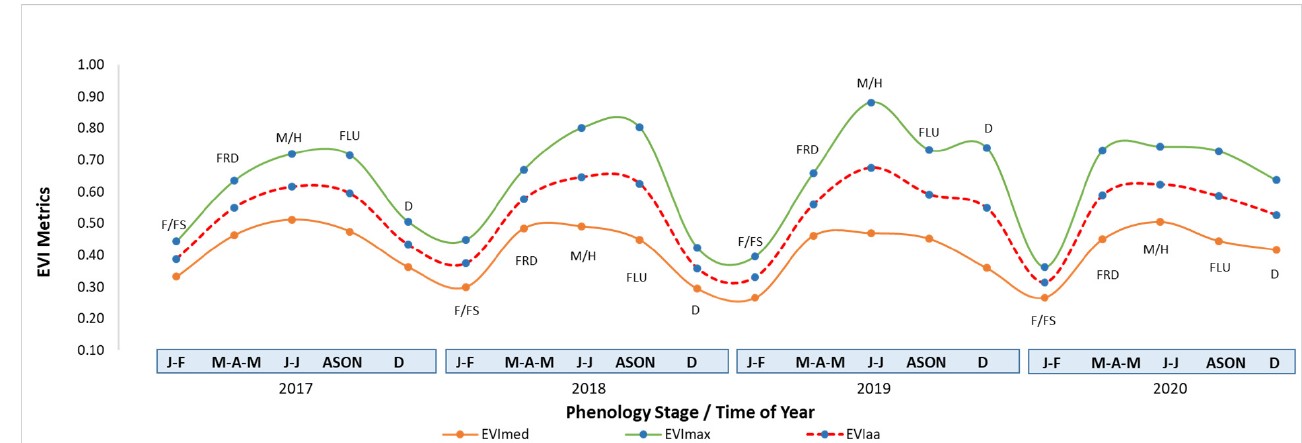
Figure 4. Temporal profile of mango in relation to the phenology cycle across the 4-year time series of median and maximum EVI metrics (EVI med , EVI max ) together with their overall yearly average (EVI aa ) from the Pentacom